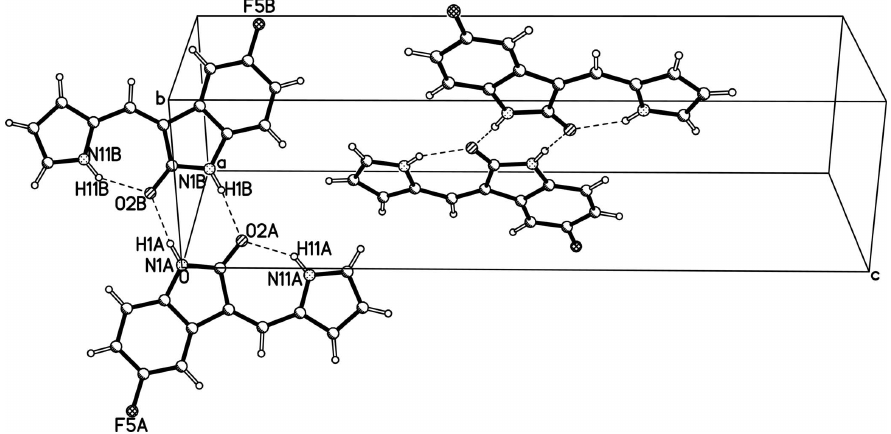
Figure 2 A unit cell packing view of the title compound. Dash lines indicate the intra- and intermolecular hydrogen bonds. H atoms are presented as open circles with arbitrary